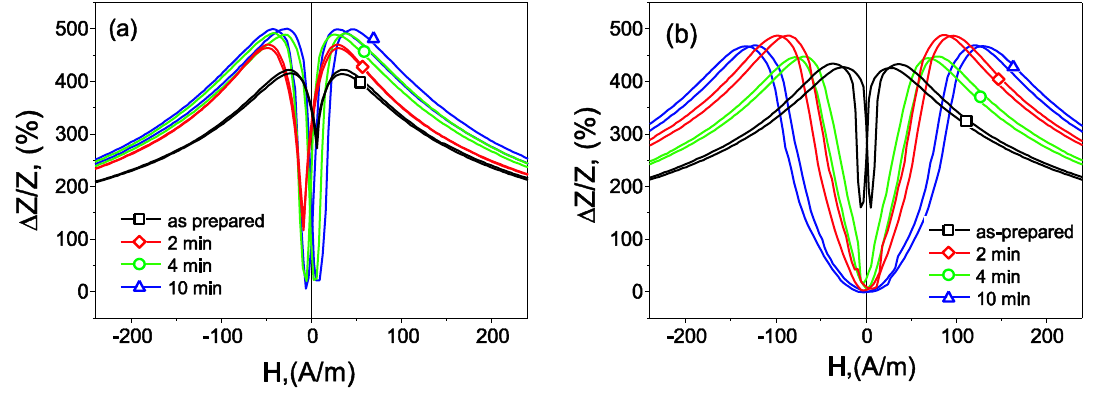
Fe Ni B Si Mo microwire [34]. 67 3.85 1.45 11.5 14.5 1.7